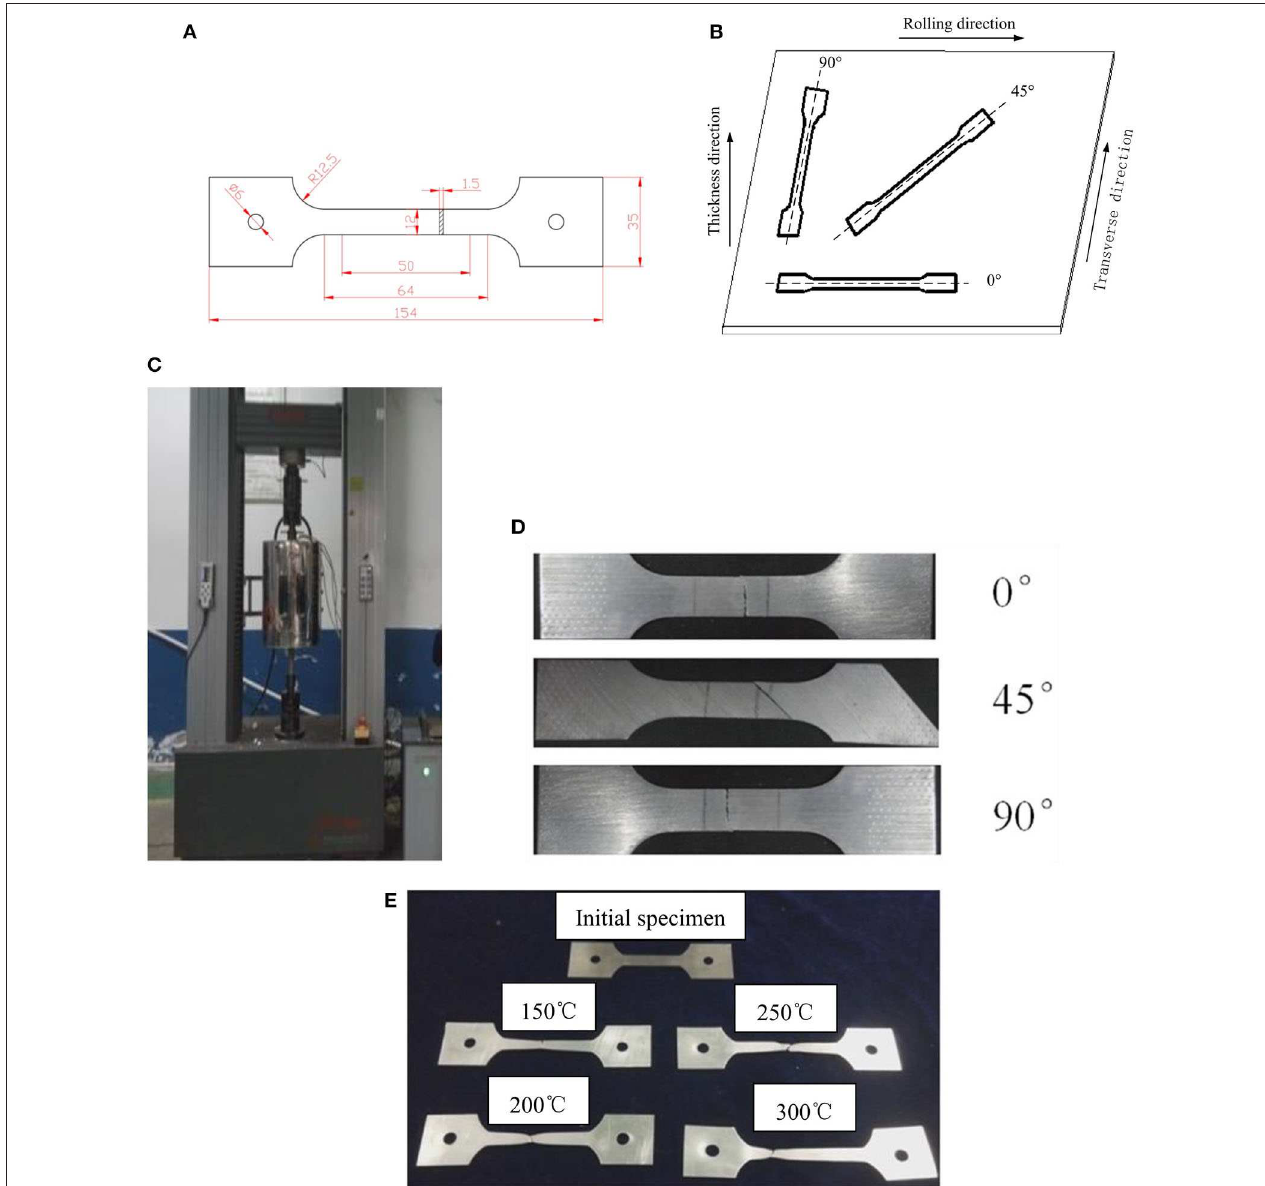
FIGURE 1 | Diagrams and photos of tensile test: (A) dimensions of tensile specimen; (B) cutting directions of specimen; (C) the photo of tensile testing machine; (D) the photo of fractured specimen at room temperature; (E) the photo of fractured specimen in 0 ◦ direction at different temperatures.